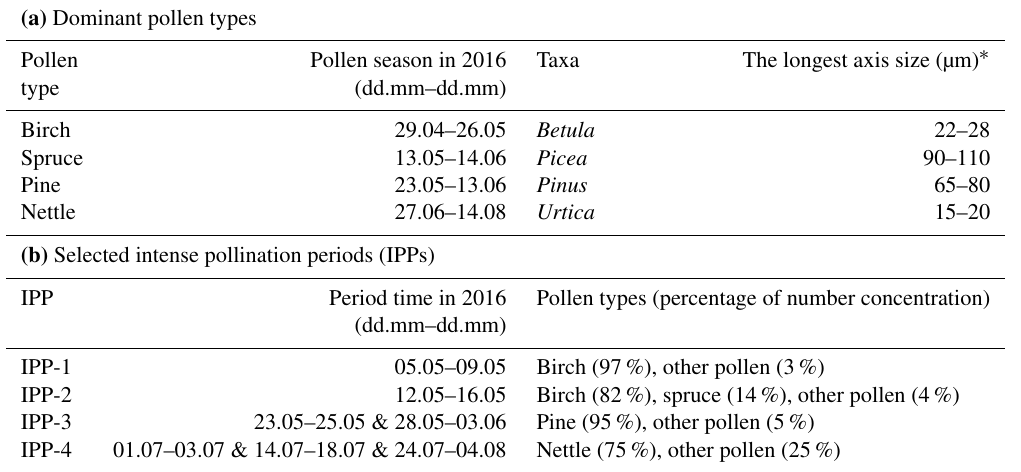
Table 3. (a) Dominant pollen types with their pollen season period, Latin name (taxa), and typical size. (b) Selected intense pollination periods (IPPs) and the presented dominant pollen types during each IPP. See more descriptions in Sect.